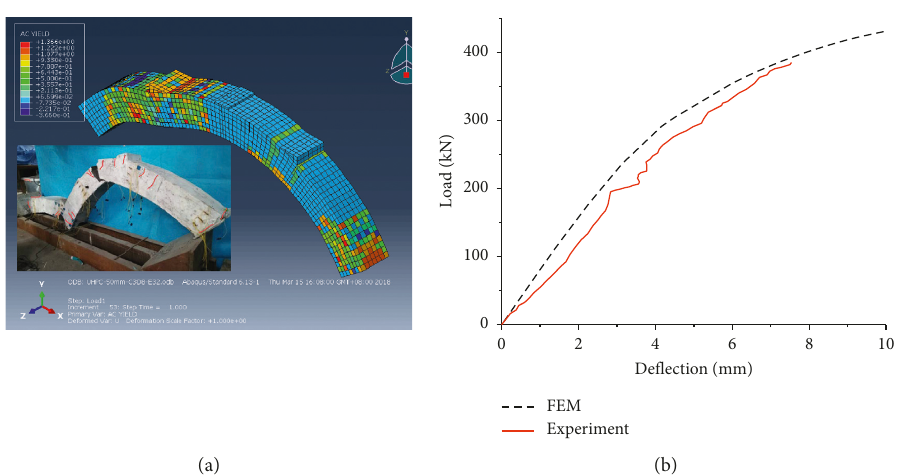
Figure 15: Comparison of experiment and FEM results. (a) Crack pattern. (b) Load-deflection behavior.